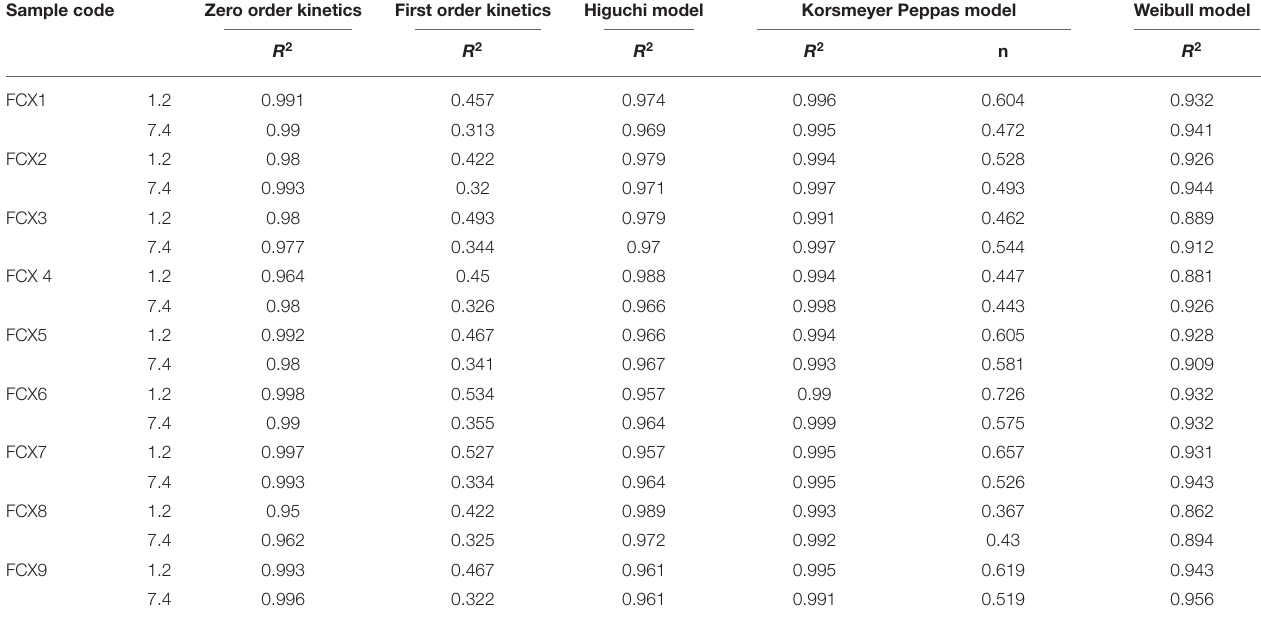
TABLE 3 | Determination of regression coefficient R 2 and release exponent “ n ” from developed hydrogels. Sample